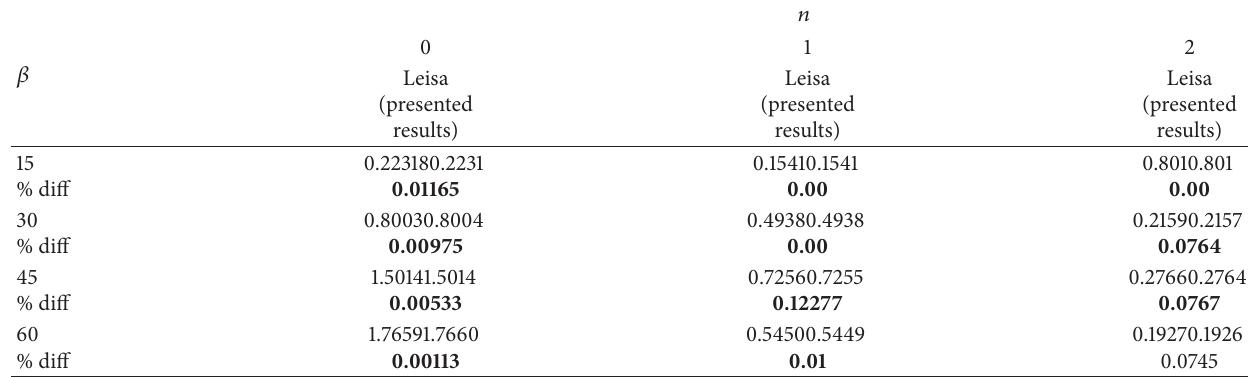
Table 3: Nondimensional frequency of a fixed conical shell with a fixed vertex.